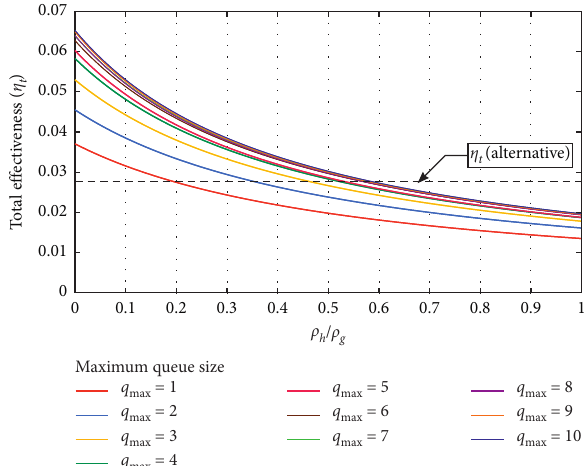
Figure 12: Comparing the HGMP with an alternative model where each agent does both exploration and completion